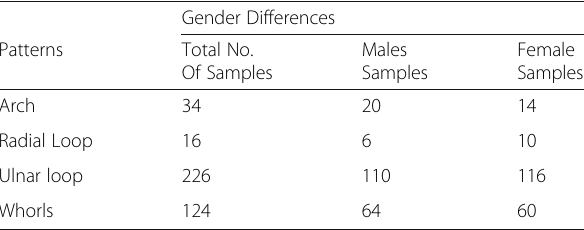
Table 1 Show the Gender differences in general pattern types among 400